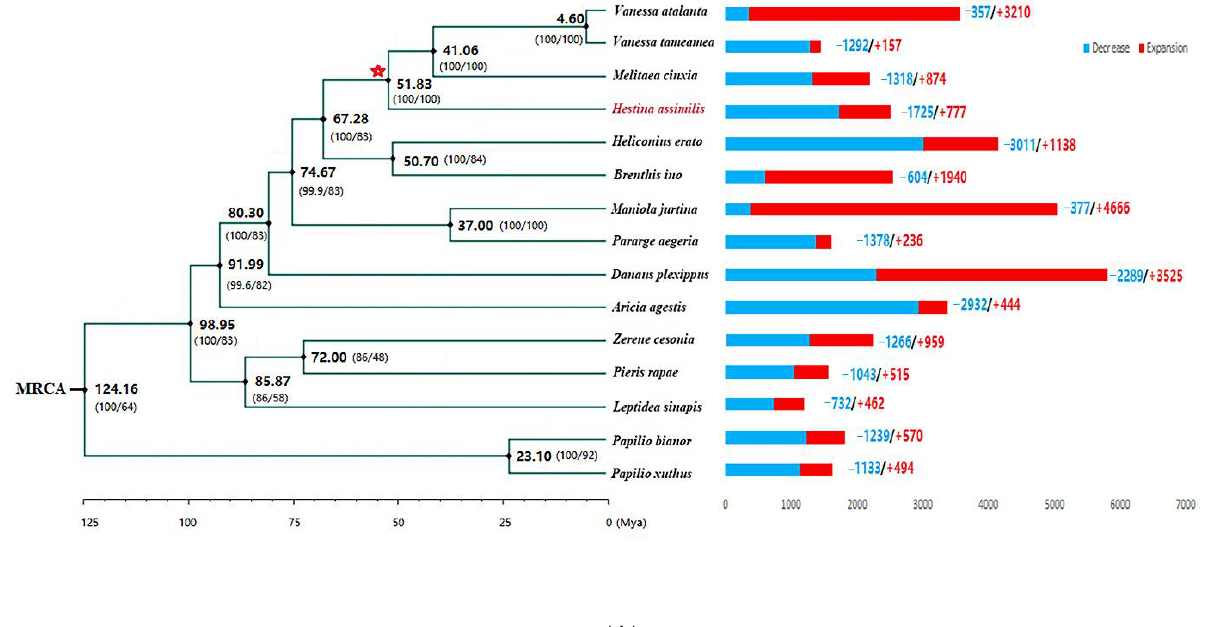
Figure 1. Synteny alignment of the genome of H. assimilis (male), M. cinxia (male), and D. plexippus (male). The tagged HA01 to HA30 refer to the chromosomes of the sequenced H. assimilis , the green